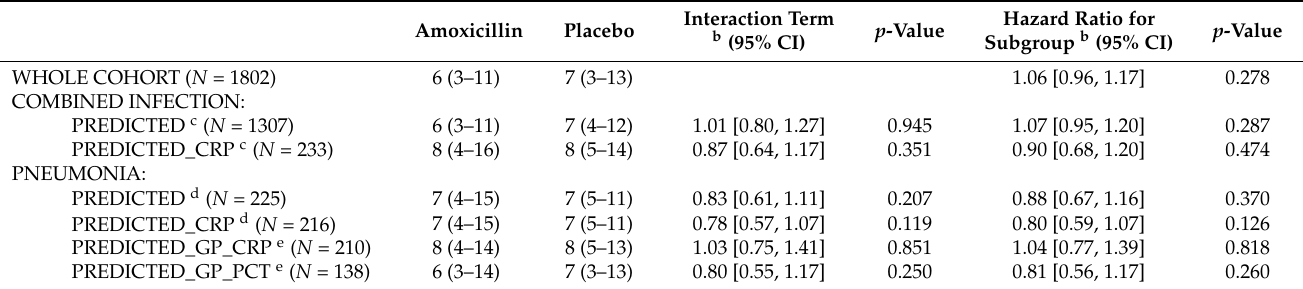
Table 2. Median symptom duration a (interquartile range) in patients presenting to primary care with acute cough treated with amoxicillin versus placebo.